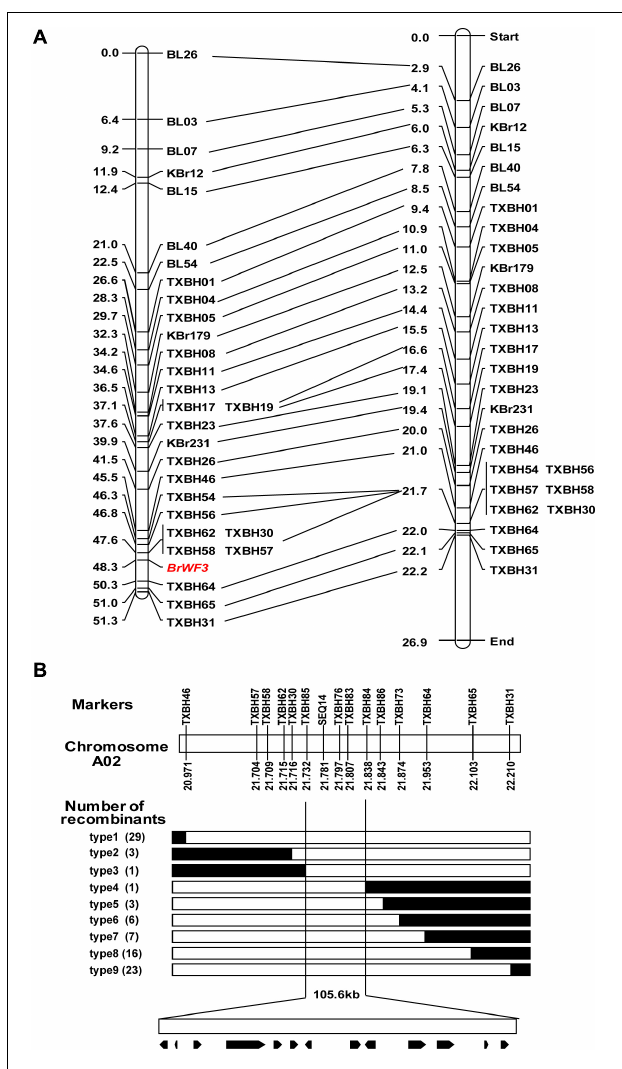
FIGURE 3 | Initial and fine mapping of the BrWF3 gene in Chinese cabbage. (A) Initial mapping of BrWF3 . Genetic map of BrWF3 is on the left, with cM as the unit. The corresponding physical map (right, unit: Mb) are also shown. (B) Fine mapping of BrWF3 . The BrWF3 gene was delimited to an interval between TXBH85 and TXBH84, with an estimated length of 105.6 kb, and 13 genes were annotated in this region based on the reference genome sequence. The genetic structure of each recombinant type is depicted as white for homozygous white flower, black for heterozygous alleles, respectively. The number of each recombinant type is indicated in the